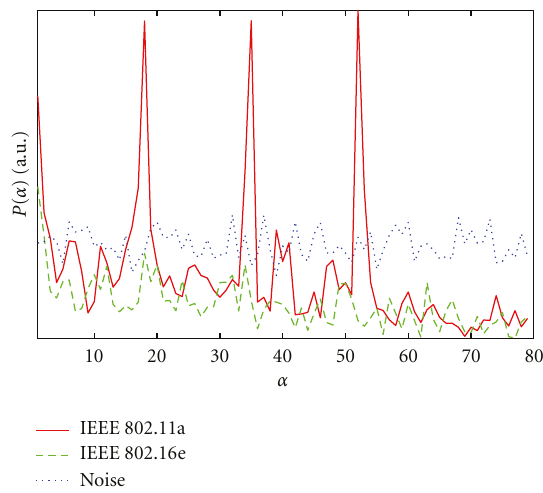
Figure 4: Projection P ( α ) for an IEEE 802.11a signal, an IEEE 802.16e signal, and no transmission (noise) with L = 500 and /N E = b 0